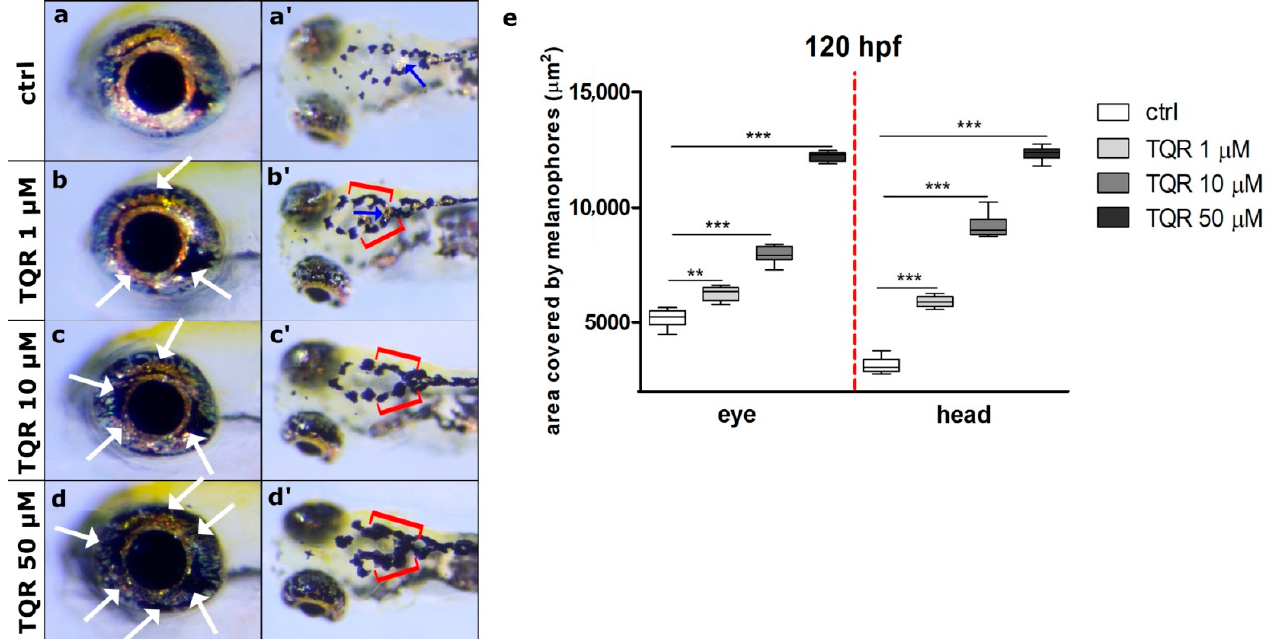
Figure 3. Dose-dependent increase in zebrafish melanophore pigmentation following exposure to tariquidar (TQR) at 120 h post fertilization (hpf). A set of photographs presenting lateral and dorsal views of 120 hpf zebrafish larvae displaying effects of 116 h TQR exposure on the melanophore pigmentation within the eye and dorsal head in four experimental groups: ( a,a’ ) control, ( b,b’ ) exposed to TQR 1 µM, ( c,c’ ) exposed to TQR 10 µM, and ( d,d’ ) exposed to TQR 50 µM. The control larvae presented normal melanophore distribution within both the eye and dorsal head ( a , a’ ). At 120 hpf, the effects of TQR exposure were the continuation of those observed at 72 hpf; however, they were more intense. Progressive hypermelanogenesis was observed with increasing concentration ( b,b’; c,c’; d,d’ ). In the area of the eye, the melanophores began to occupy the area normally covered by the iridophores ( b,c,d ) (white arrows). Within the dorsal head in the control group, the melanophores were separated and small, while in the TQR exposed groups they were expanded and started to merge creating form closely apposed groups ( b’,c’,d’ ) (red buckle). Additionally, in the control ( a’ ) and 1 µM TQR-exposed group ( a’ ) in the central part of the head, the iridophores were visible (blue arrows), while in 10 µM TQR- and 50 µM TQR-exposed groups these cells were not found. ( e ) A graph presenting the area covered by melanophores (µm 2 ) measured at 120 h post fertilization (hpf) within the eye and dorsal head (one-way ANOVA/Kruskal–Wallis, GraphPad Prism 5, *** p < 0.001, ** p < 0.01).